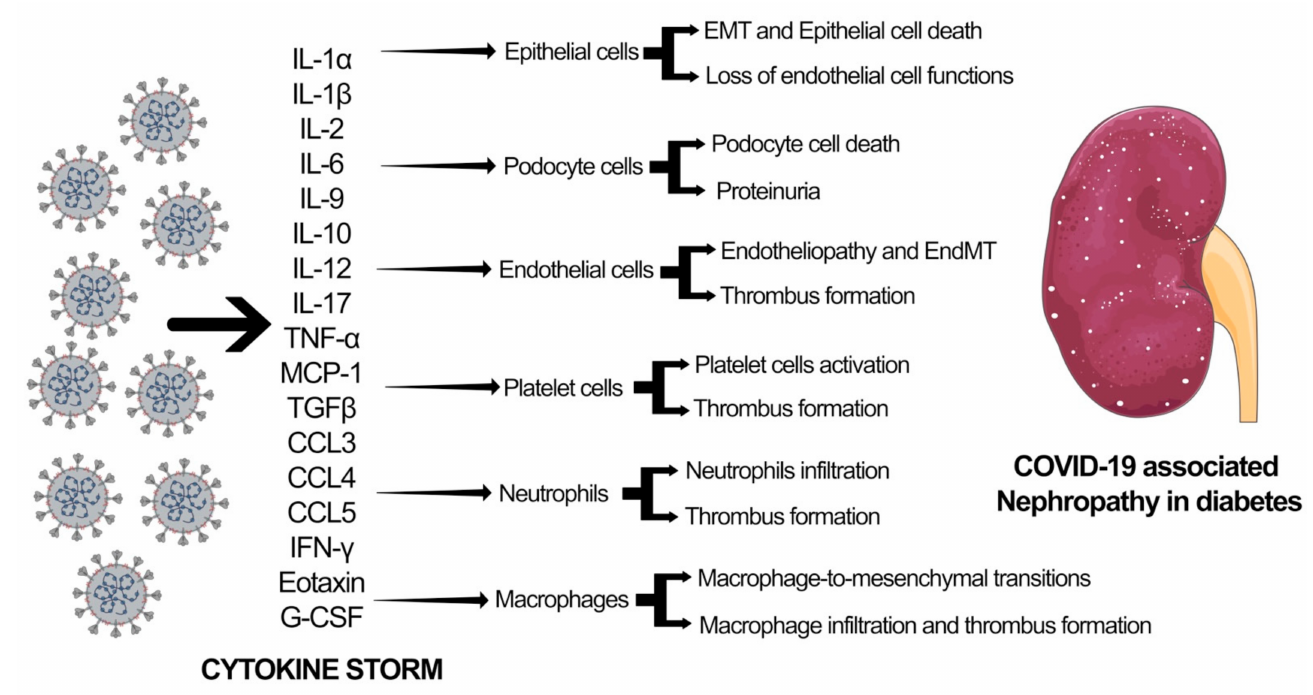
Figure 2. Mechanisms related to COVID-19 associated nephropathy in